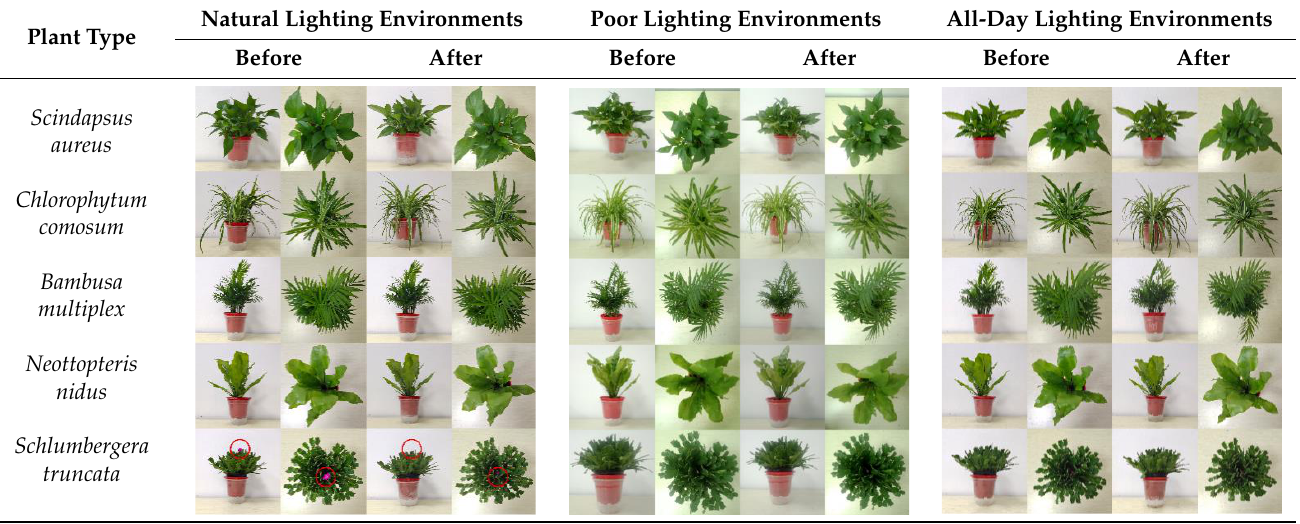
Table 1. Comparison of the status of five indoor plants selected for the experiment before and after the experiment (30 days).